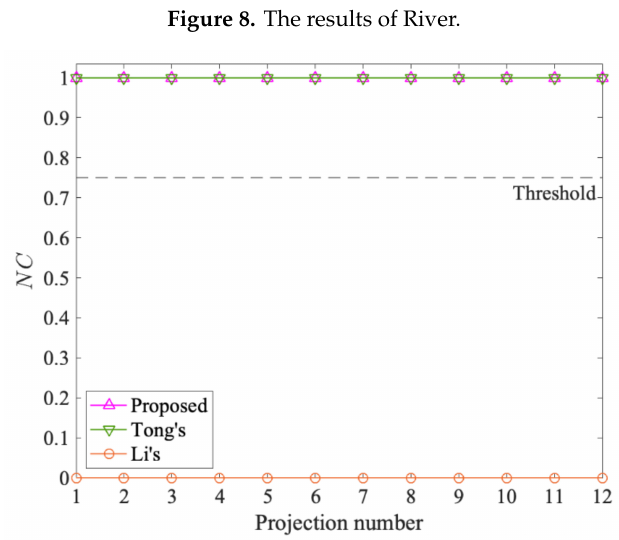
Figure 8. The results of River.